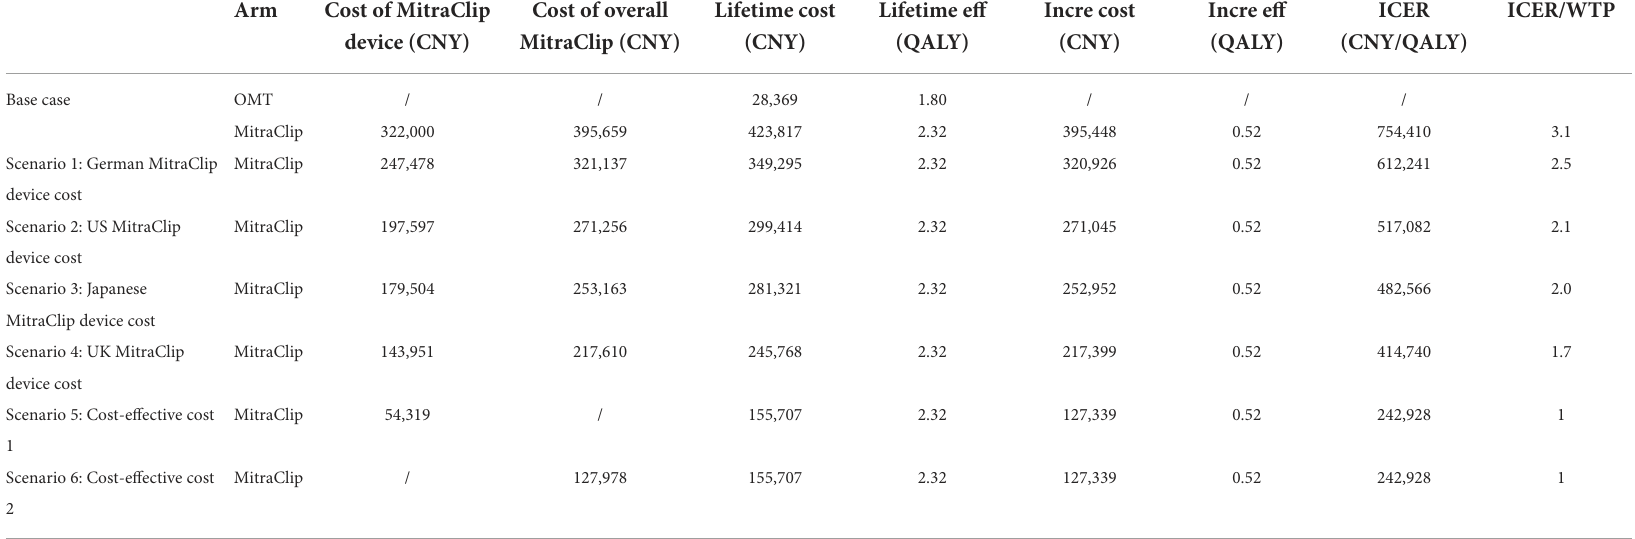
TABLE 4 Base case analysis and scenario